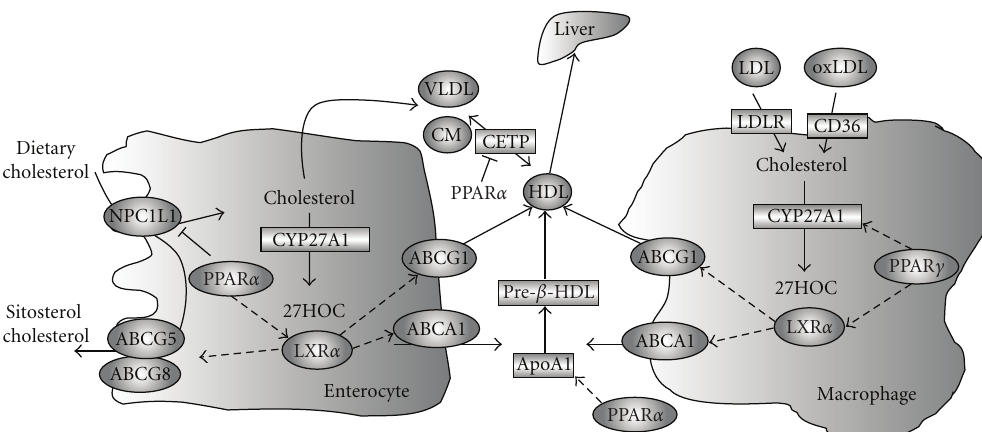
Figure 3: Reverse cholesterol transport. In the intestine, dietary uptake of cholesterol is mediated by NPC1L1. ABCG5/G8 e ffl uxes sitosterols and cholesterol back to the intestine lumen and limits intestinal sterol absorption. Oxysterols activate LXR, which induces ABCA1 and ABCG1 to transport cholesterol to ApoA1 and HDL, respectively. PPAR α activation reduces NPC1L1 and fractional cholesterol absorption, and may promote cholesterol secretion by stimulating CYP27A1 and LXR activation of ABCA1 and ABCG1. In macrophages, LDLR and CD36 mediate LDL and oxidized-LDL uptake, respectively. CYP27A1 converts cholesterol into 27-hydroxycholesterol, which may activate LXR and cholesterol e ffl ux via ABCA1 and ABCG1. Cholesterol can also be secreted in the form of 27-hydroxycholesterol. PPAR γ induces CYP27A1 and LXR, and positively regulates the cholesterol e ffl ux from macrophages. PPAR α induces ApoA1 and inhibits CETP, and thus increases circulating HDL-C